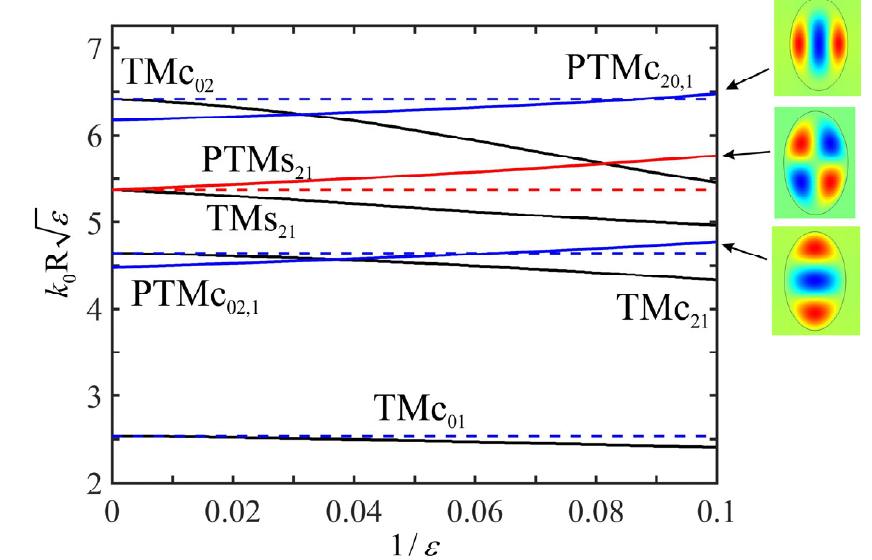
Figure 7. Eigenfrequencies k 0 R ε of even ((30), blue curves) and odd ((31), red curves) perfect invisibility modes and quasi-normal modes (black curves) versus 1/ ε for the ellipse with a / b = 1.6, m = 0, 2. The horizontal dashed lines correspond to the confined modes, that is, the solution of the equations Ce m ( ξ 0 , q ) = 0 and Se m ( ξ 0 , q ) = 0. The insets show the H z distribution for the PTM modes.